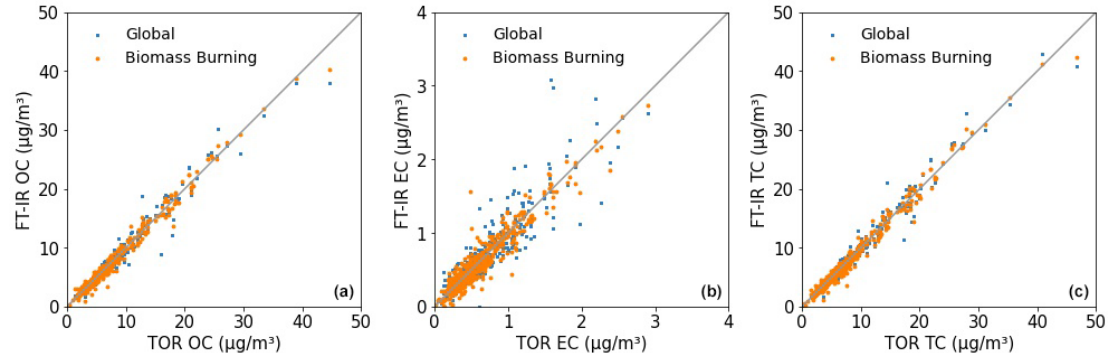
Figure 3. Inter-model OC (a) , EC (b) , TC (c) comparison between global (Sect. S1) and biomass burning predicted concentrations for the 492 samples classified as biomass burning in 2015. EC prediction, in particular, benefit from having a dedicated biomass burning calibration model. Table 1. Summary of Multilevel model performance for IR-active atmospheric constituents for 19608 spectra analyzed by FT-IR in the year 2015. Species R 2 Bias Bias Error Error Reference data MDL < MDL (µgm − 3 ) (%) (µgm − 3 )